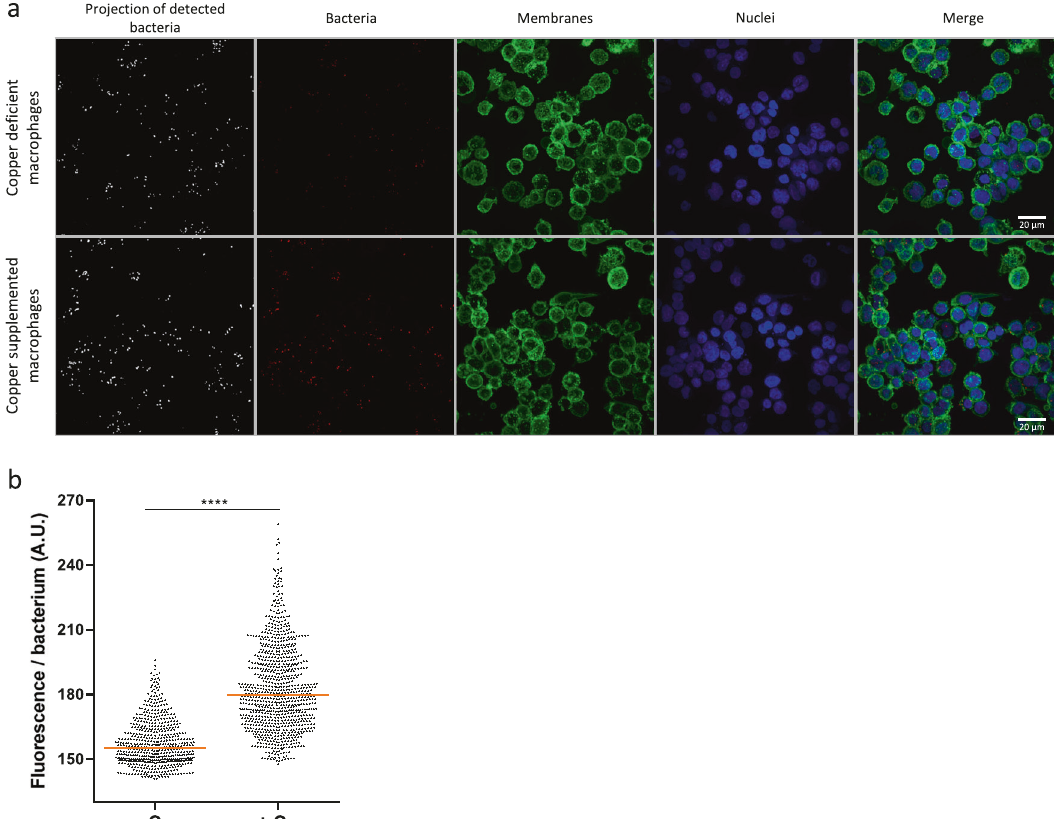
Fig. 7 Upregulation of the operon in macrophages. a Representative images of THP1 macrophages having engulfed B. pertussis harboring the mRPF1 gene under the control of the copZ-prxgrx-gorB operon promoter. Macrophages were either starved of copper using a chelator or treated with copper chloride prior to contact with bacteria. The bacteria are red, cell membranes are green, and nuclei are blue. In the two fi elds shown at the left, the bacteria were projected as objects, showing that similar numbers are present in both conditions. All image panels are shown at the same magni fi cation. b Levels of fl uorescence (arbitrary units) of intracellular bacteria in the two conditions. Statistical analyses were performed using a two-tailed Student T-test ( ****, p < 0.0001 ). The horizontal orange lines represent median values (n > 500 in both